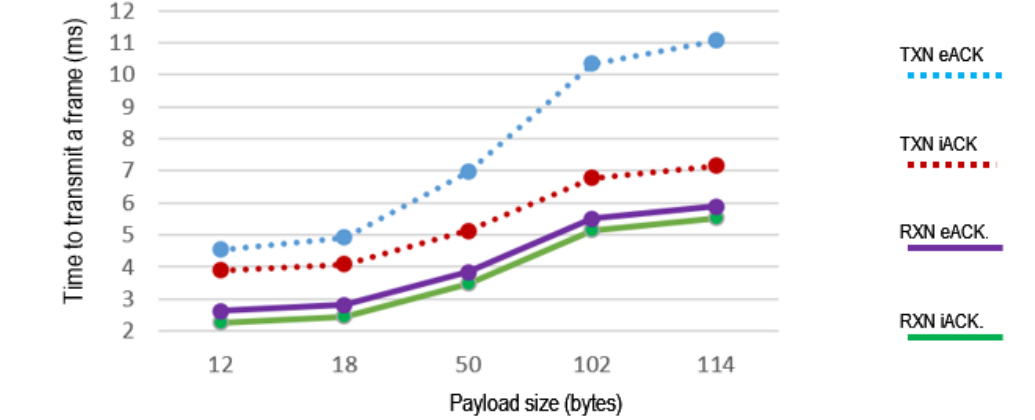
Figure 13. Delay according to the payload size.